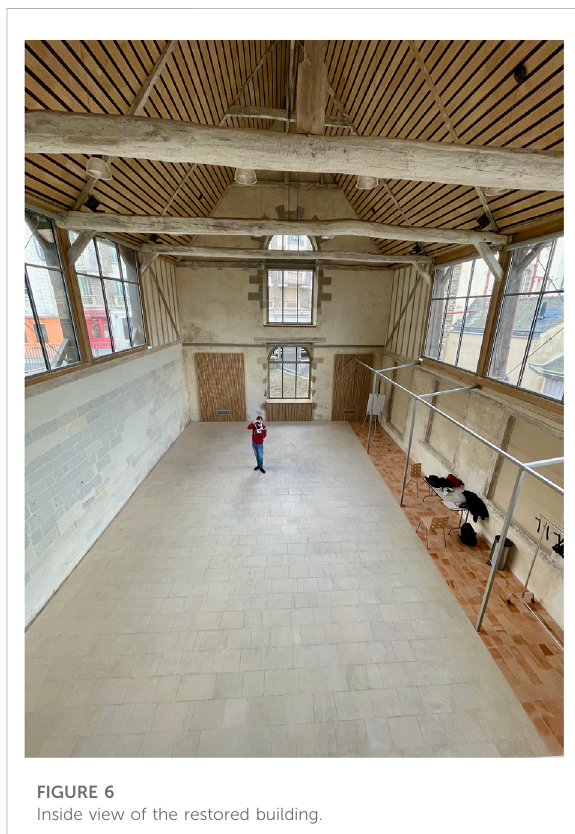
FIGURE 6 Inside view of the restored